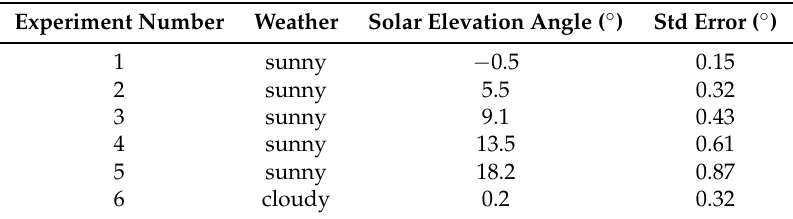
Table 3. Angle estimation errors at different solar elevation angles and different weather